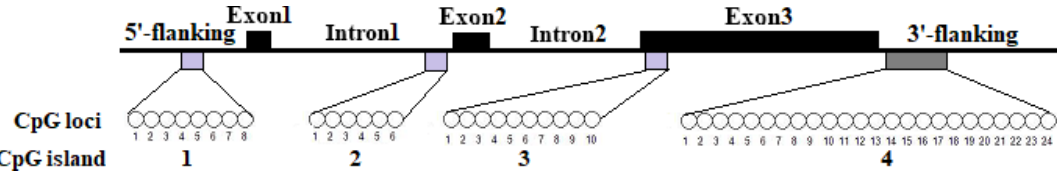
Figure 1. Gene structure and CpG islands distribution within the goat PITX1 gene.